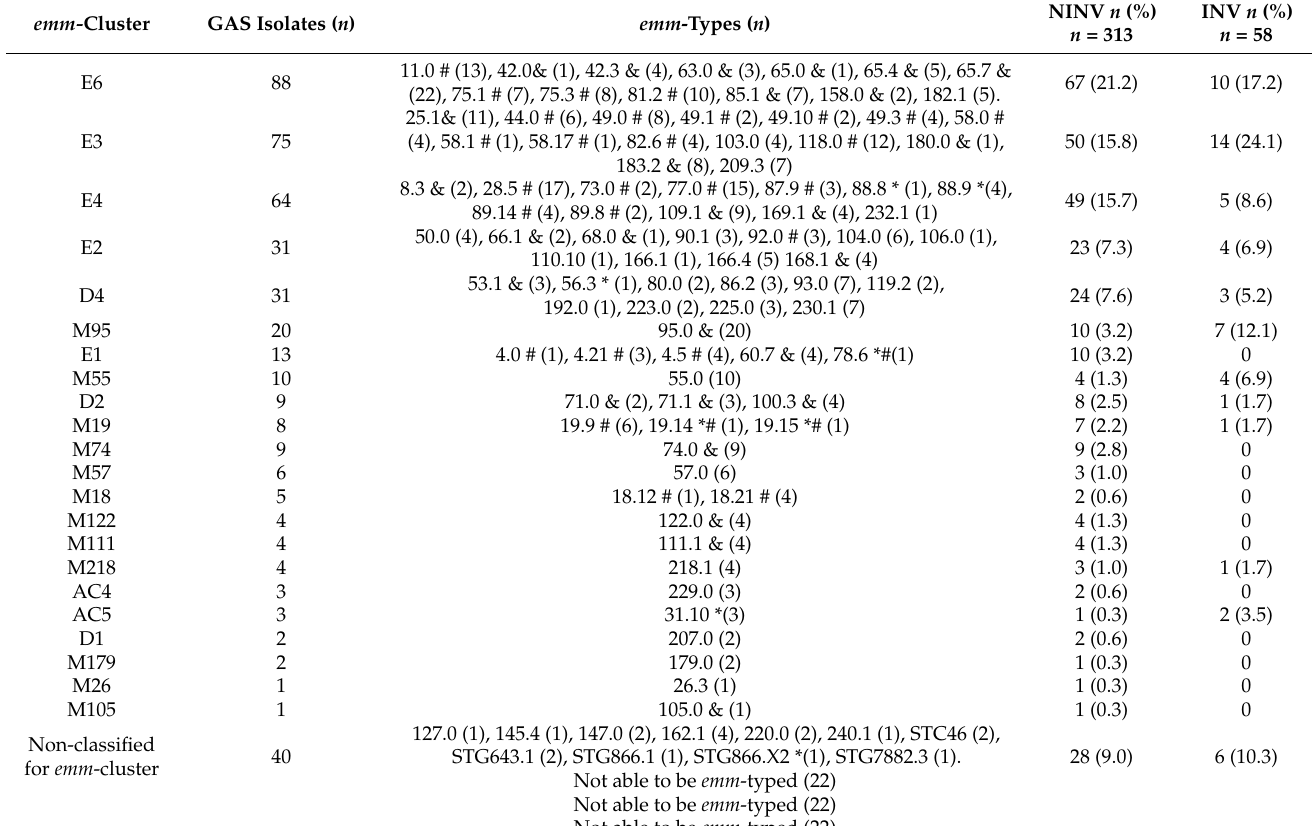
Eighty emm -types were identified among the 433 GAS isolates, encompassing 22 emm - clusters. Most emm -types (76.3%; n = 61) belonged to 5 emm -clusters, and of those remain- ing, 13 emm -types represented 13 single-type clusters. Twenty-two GAS isolates were considered non-typeable (Table 1). No novel emm -types were identified, but eight new emm -sequences were submitted to the American Center for Disease Control (CDC) and were identified as new subtypes (Table 1). Those new sequences have been included in the worldwide database (https://www.cdc.gov/streplab/groupa-strep/index.html). Simpson’s reciprocal index on emm- types was 41.6 (95% confidence interval (CI): 36.7–48.1), indicating considerable diversity. Table 1. emm -clusters, emm- subtypes characterized in this study ( n = 433 Group A Streptococcus (GAS) isolates), and the number of isolates by non-invasive and invasive infections ( n = 371). emm-